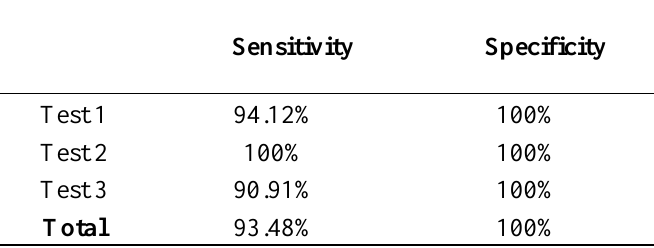
Table 11. Statistics results for arrhythmia detection.